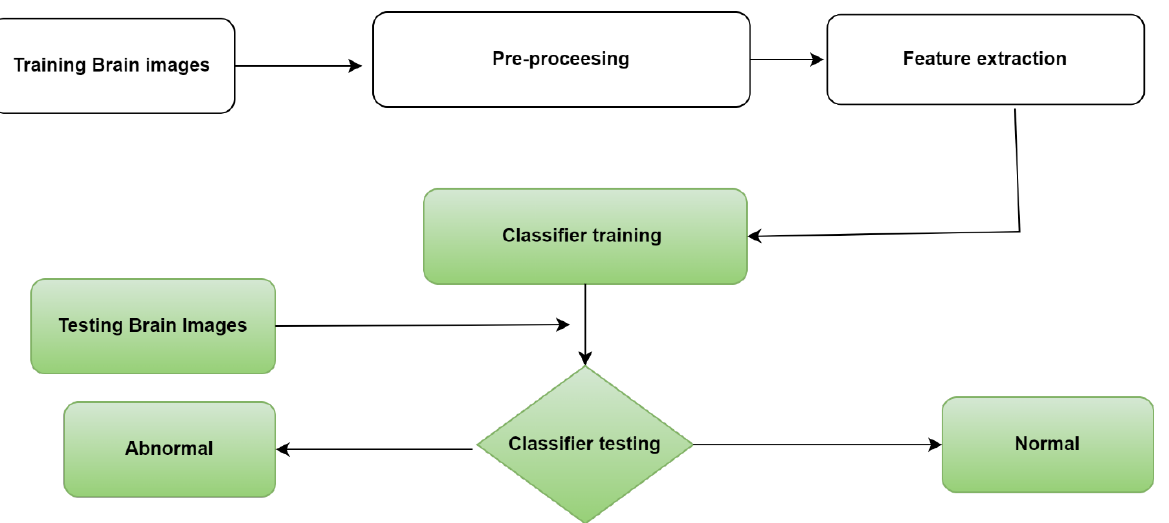
Figure 1. The main block diagram of the proposed deep tumor network for BT classification.